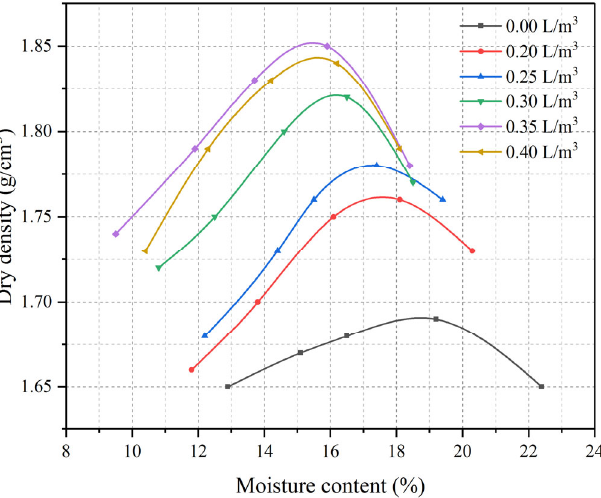
Figure 3. The relationship between concentration of F1 and Atterberg limits.